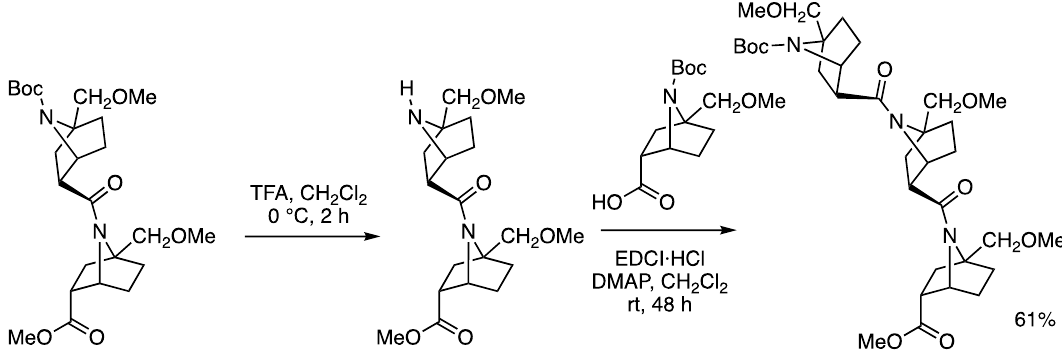
Figure 5. Acidic deprotection procedure in the synthesis of the homooligomers.